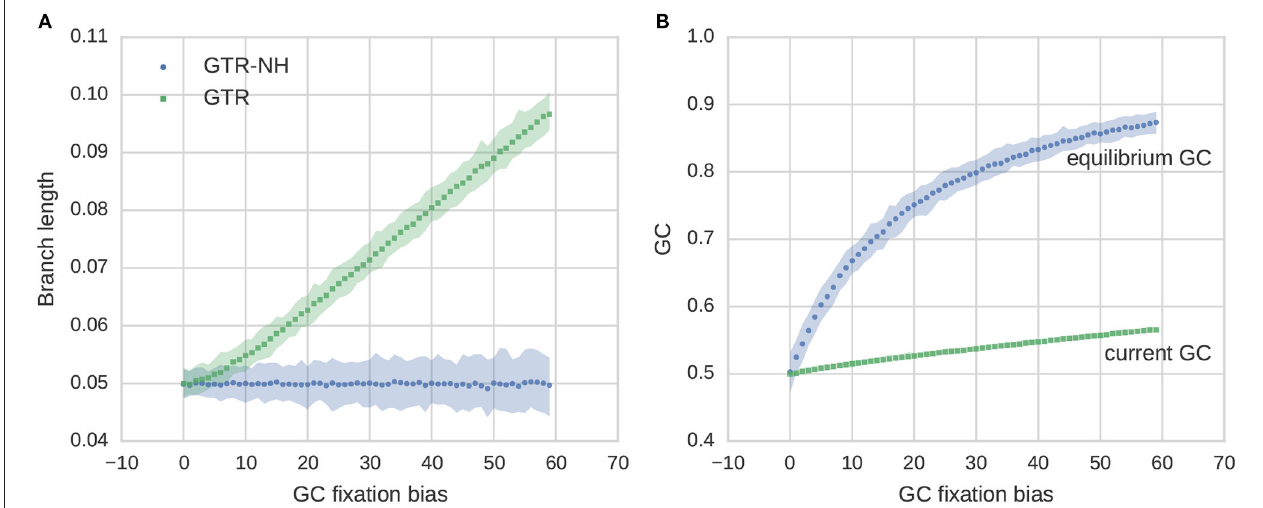
FIGURE 4 | Features of GC content evolution in a terminal branch simulated under GC fixation bias when both terminal branches (e.g., great tit and zebra finch lineage) undergo the same level of GC fixation bias and their 95% CIs. The terminal branch length under consideration is set to 0.05. (A) Estimated branch lengths under varying strength of GC fixation bias for stationary and non-stationary models. (B) GC content evolution, shown is equilibrium GC (GC*) and GC content at the tip of the branch (current GC). Because of the short branch length GC content is far from its